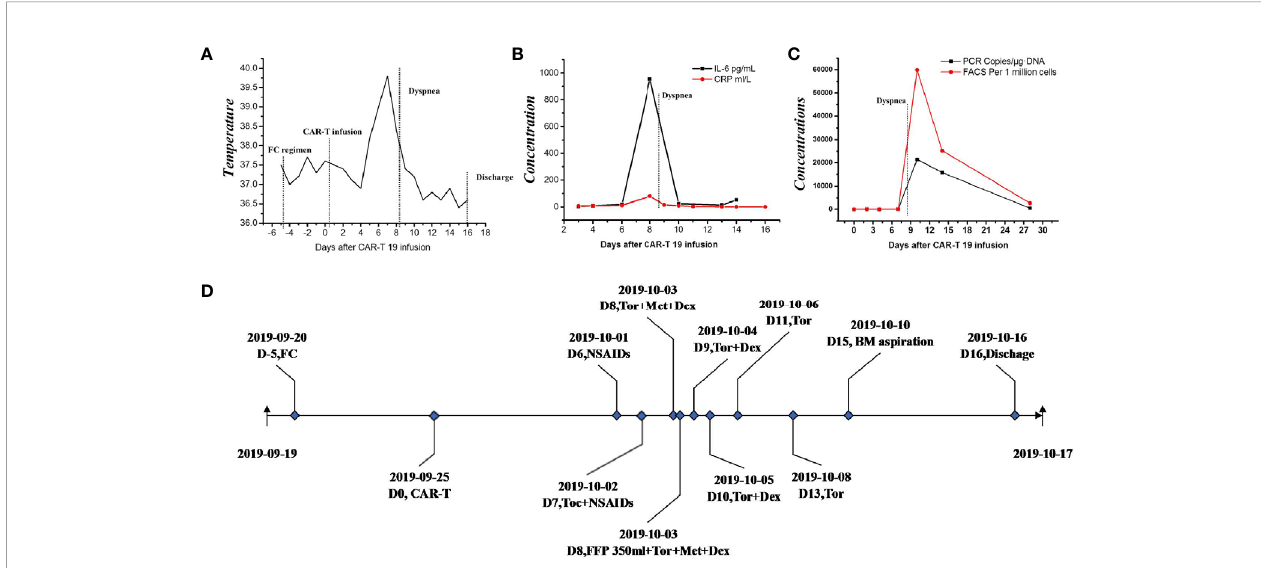
FIGURE 2 | Clinical data of L-CRS. (A) The temperature pro fi le. (B) levels of cytokine. (C) CAR-T copy number. (D) therapeutic process. FC, fl udarabine and cyclophosphamide regimen; IL-6, interleukin-6; CRP, c reactive protein; PCR, polymerase chain reaction; FACS, fl uorescence activated cell sorter; NSAIDs, non- steroidal anti-in fl ammatory drugs; Toc, tocilizumab; Tor, torasemide; Met, methylprednisolone; Dex, dexamethasone; FFP, fresh frozen plasma; BM, bone